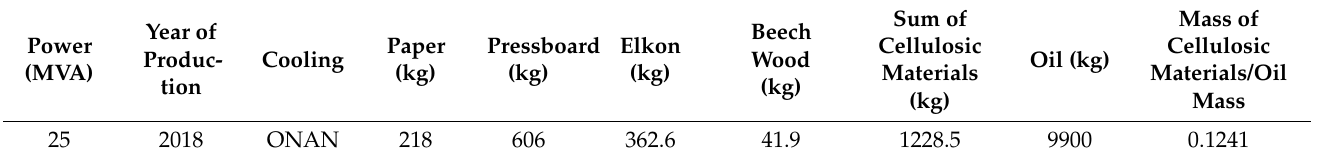
Table 4. Total mass of the insulating materials in the 25 MVA transformer [27].